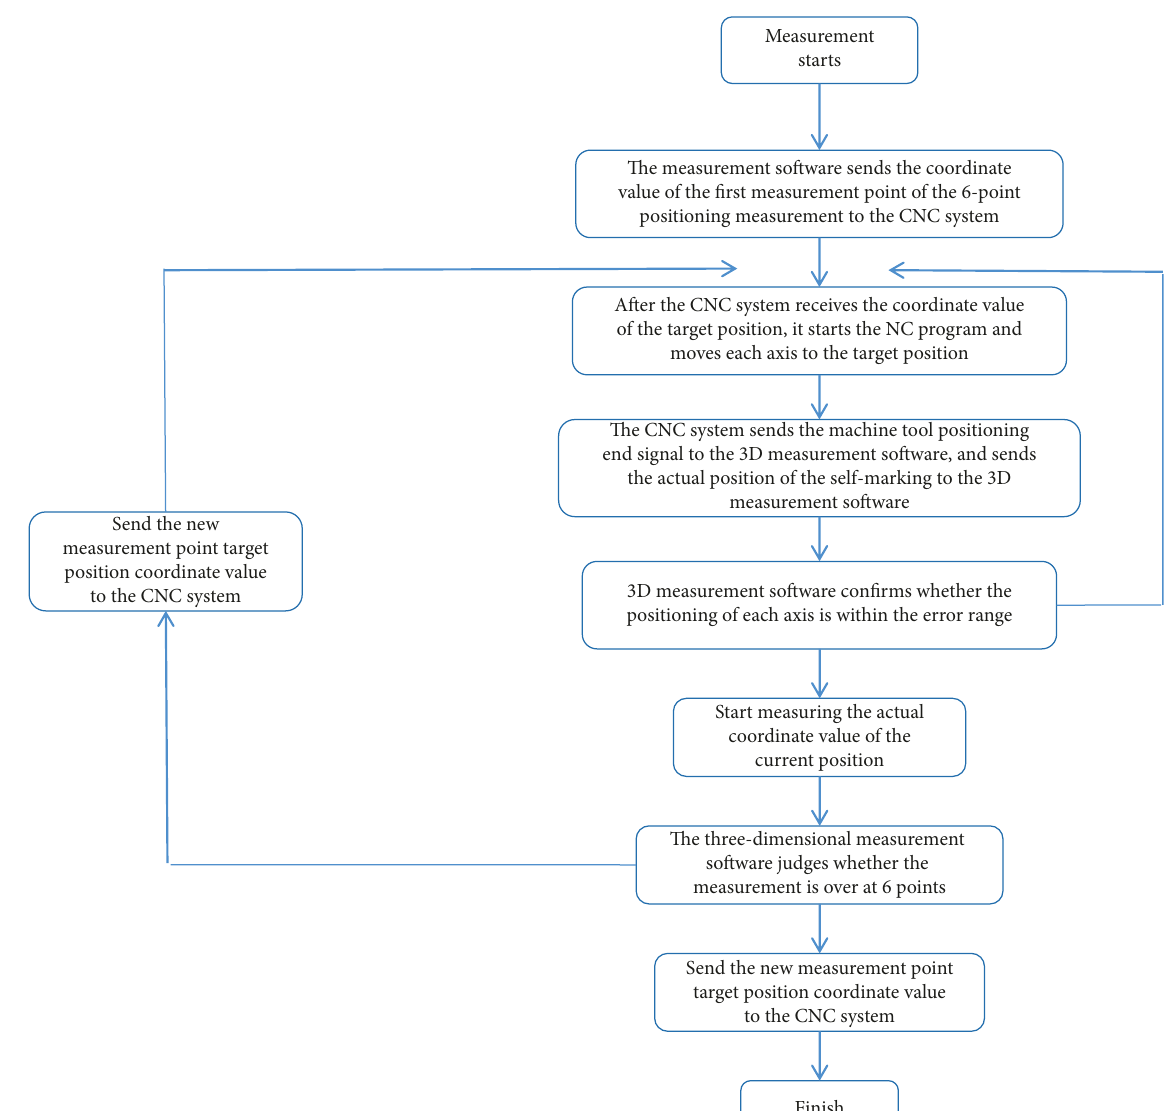
Figure 10: Workflow of the 3D measurement